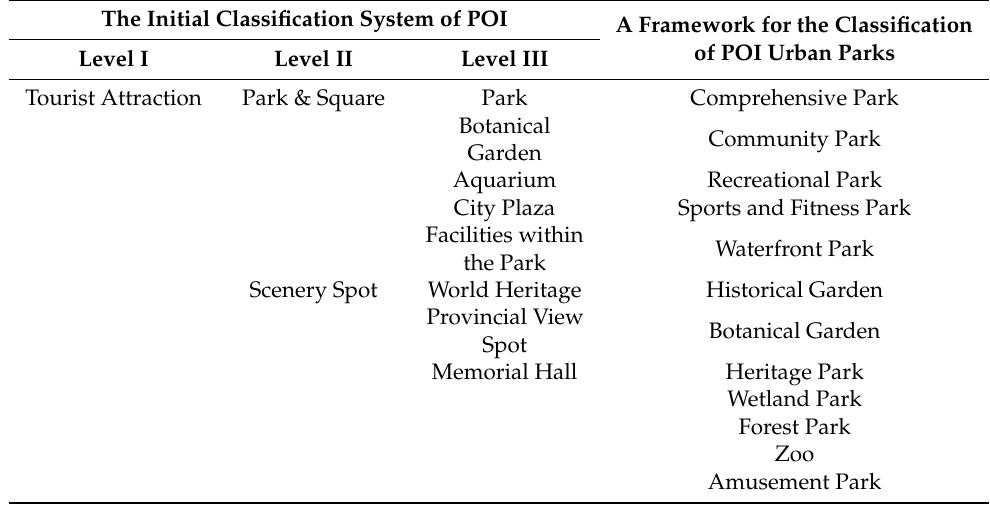
Table 3. The lookup table for reclassifying points of interest (POIs) categories into urban park types. The Initial Classification System of POI